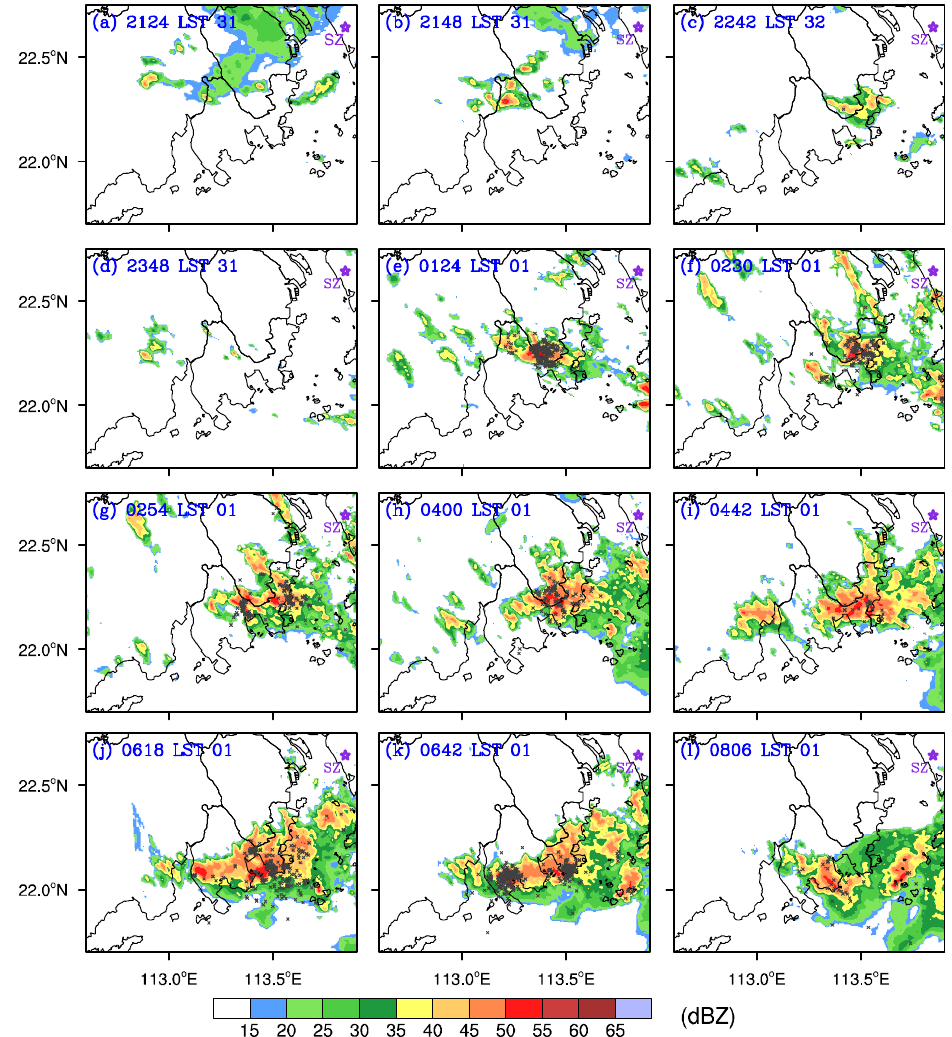
Figure 2. Radar reflectivity (Z H , dBZ) of Shenzhen (SZ) radar (1.5° elevation) (asterisk represents the location of SZ radar station) and lightning data of Earth Networks lightning detectors (black × represents lightning) at ( a ) 2124 LST 31, ( b ) 2148 LST 31, ( c ) 2242 LST 31, ( d ) 2348 LST 31, ( e ) 0124 LST 1, ( f ) 0230 LST 1, ( g ) 0254 LST 1, ( h ) 0400 LST 1, ( i ) 0442 LST 1, ( j ) 0618 LST 1, ( k ) 0642 LST 1, ( l ) 0806 LST 1.